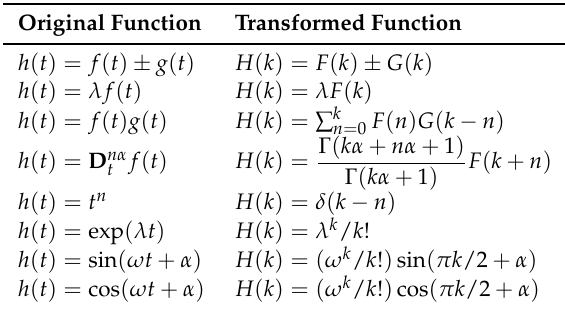
Table 1. Differential Transformations